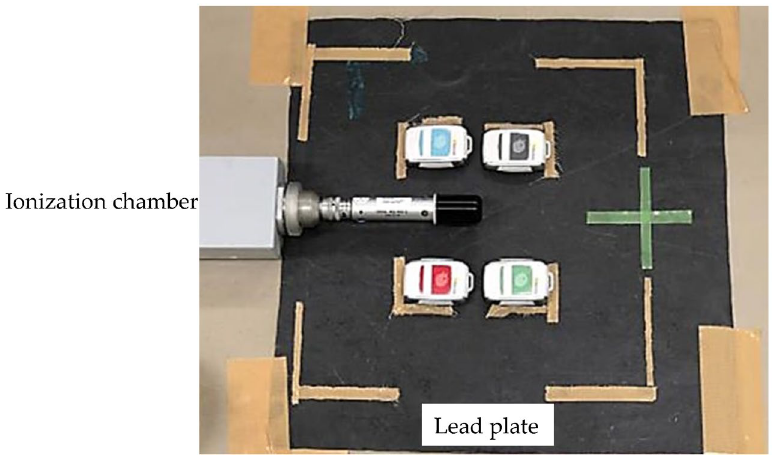
Figure 3. Experimental layout. The exposed area (radiation field) at the i3 entrance was 30 × 30 cm.